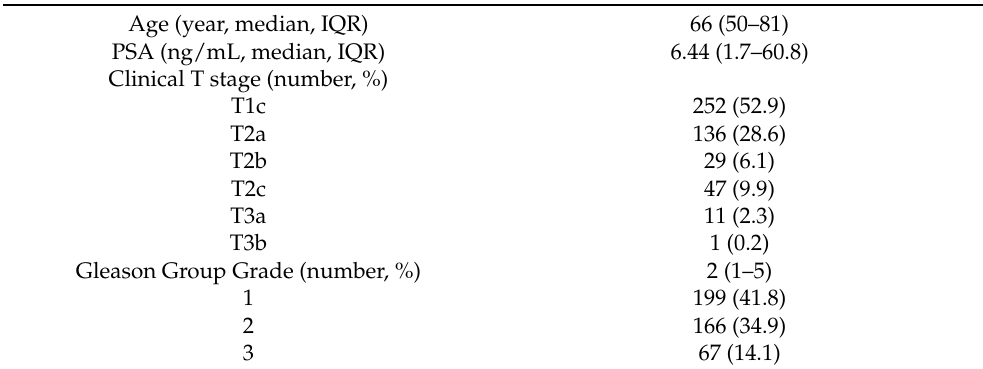
Table 1. Patient